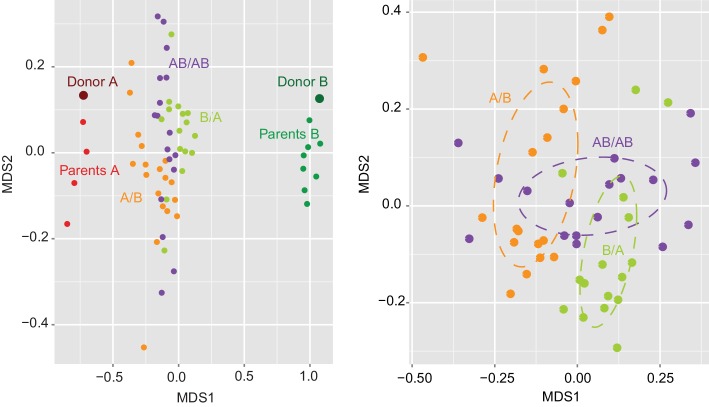
Determination of the importance of colonization history in mouse experiments using whole donor microbiomes.NMDS plot based on Jaccard dissimilarities of donors A (n = 1) and B (n = 1), parents A (n = 4) and B (n = 4), and A/B (n = 18), B/A (n = 16), and AB/AB (n = 17) mice.